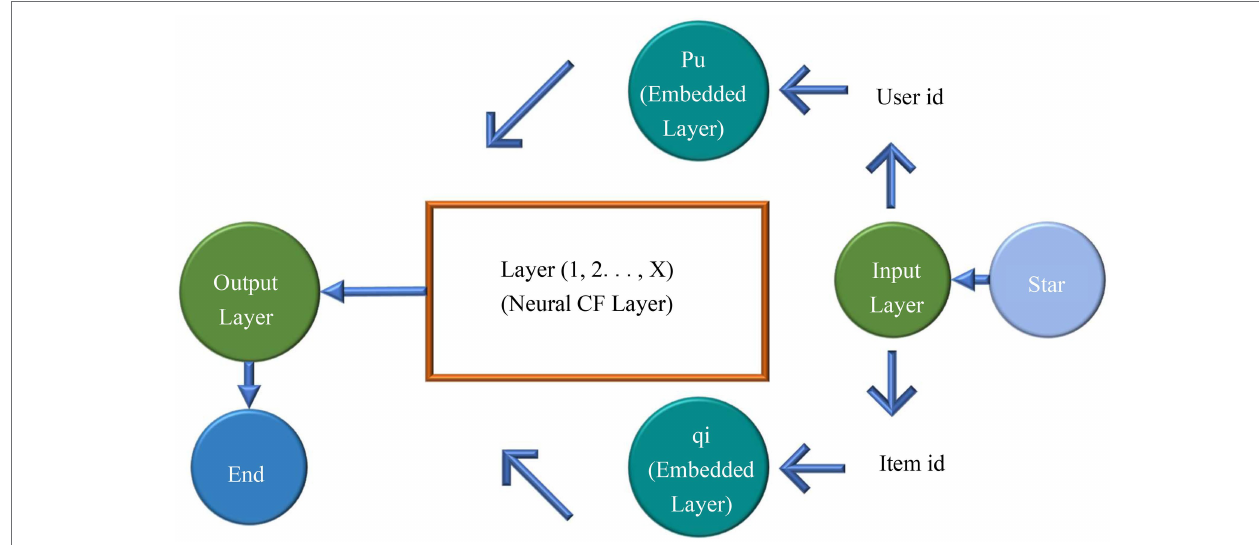
FIGURE 5 | Framework of multi-layer perceptron